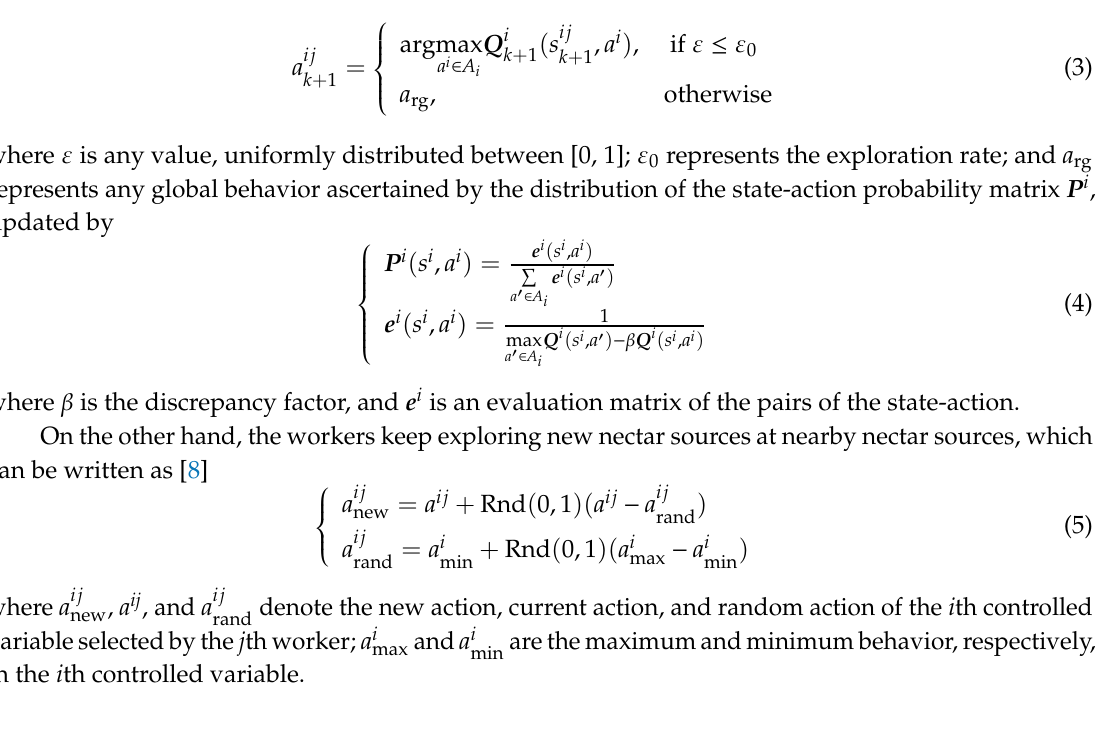
Figure 3. Behavior transfer of the TBO.